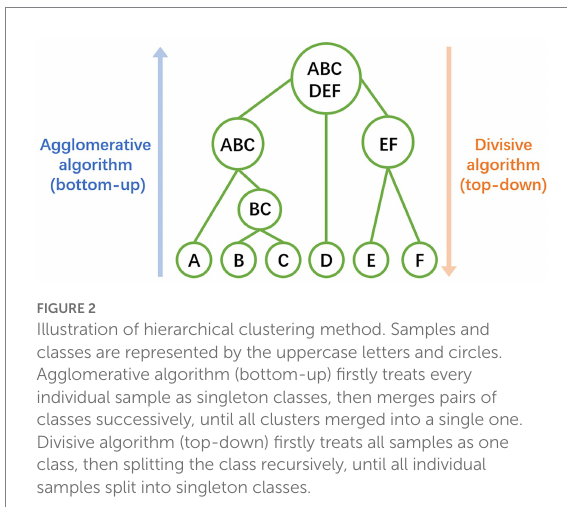
FIGURE 2 Illustration of hierarchical clustering method. Samples and classes are represented by the uppercase letters and circles. Agglomerative algorithm (bottom-up) firstly treats every individual sample as singleton classes, then merges pairs of classes successively, until all clusters merged into a single one. Divisive algorithm (top-down) firstly treats all samples as one class, then splitting the class recursively, until all